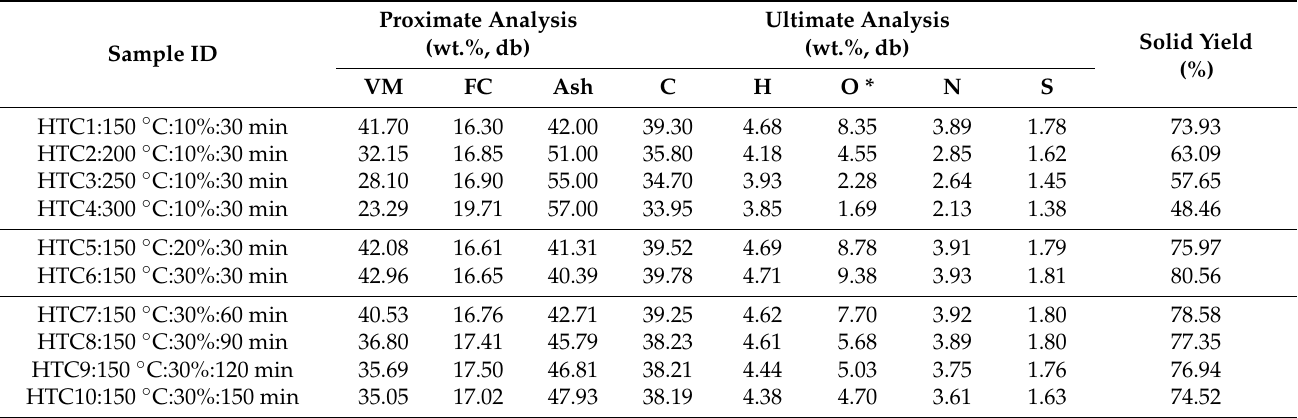
Table 3. Proximate and ultimate analysis of